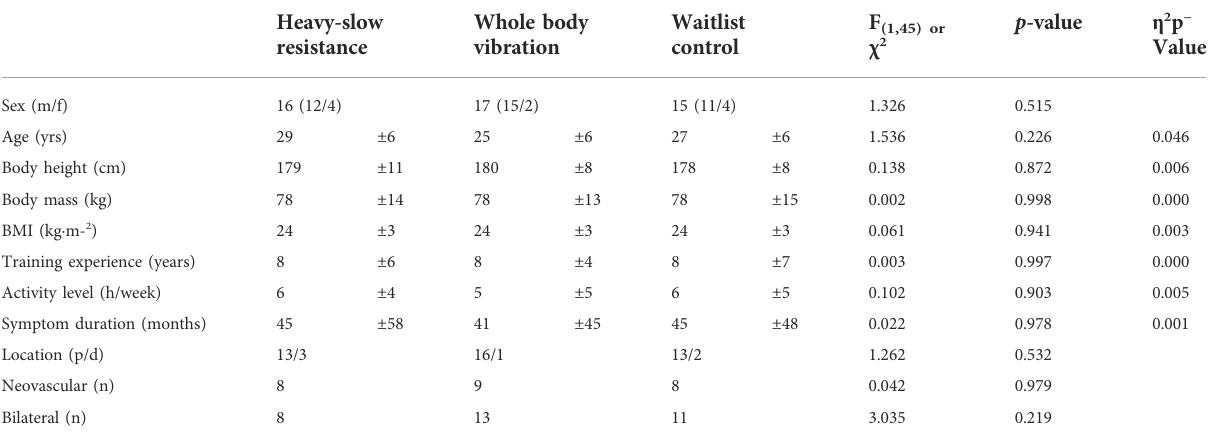
TABLE 1 Baseline subject